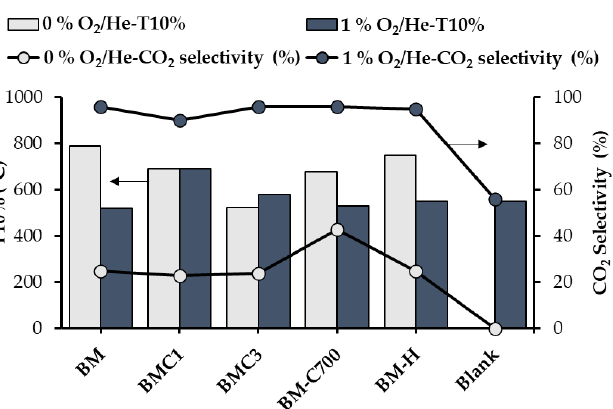
Figure 10. Temperature to achieve 10% soot conversion (T10%) and CO 2 selectivity values in He and 1% O 2 /He for BaMnO 3 catalysts.